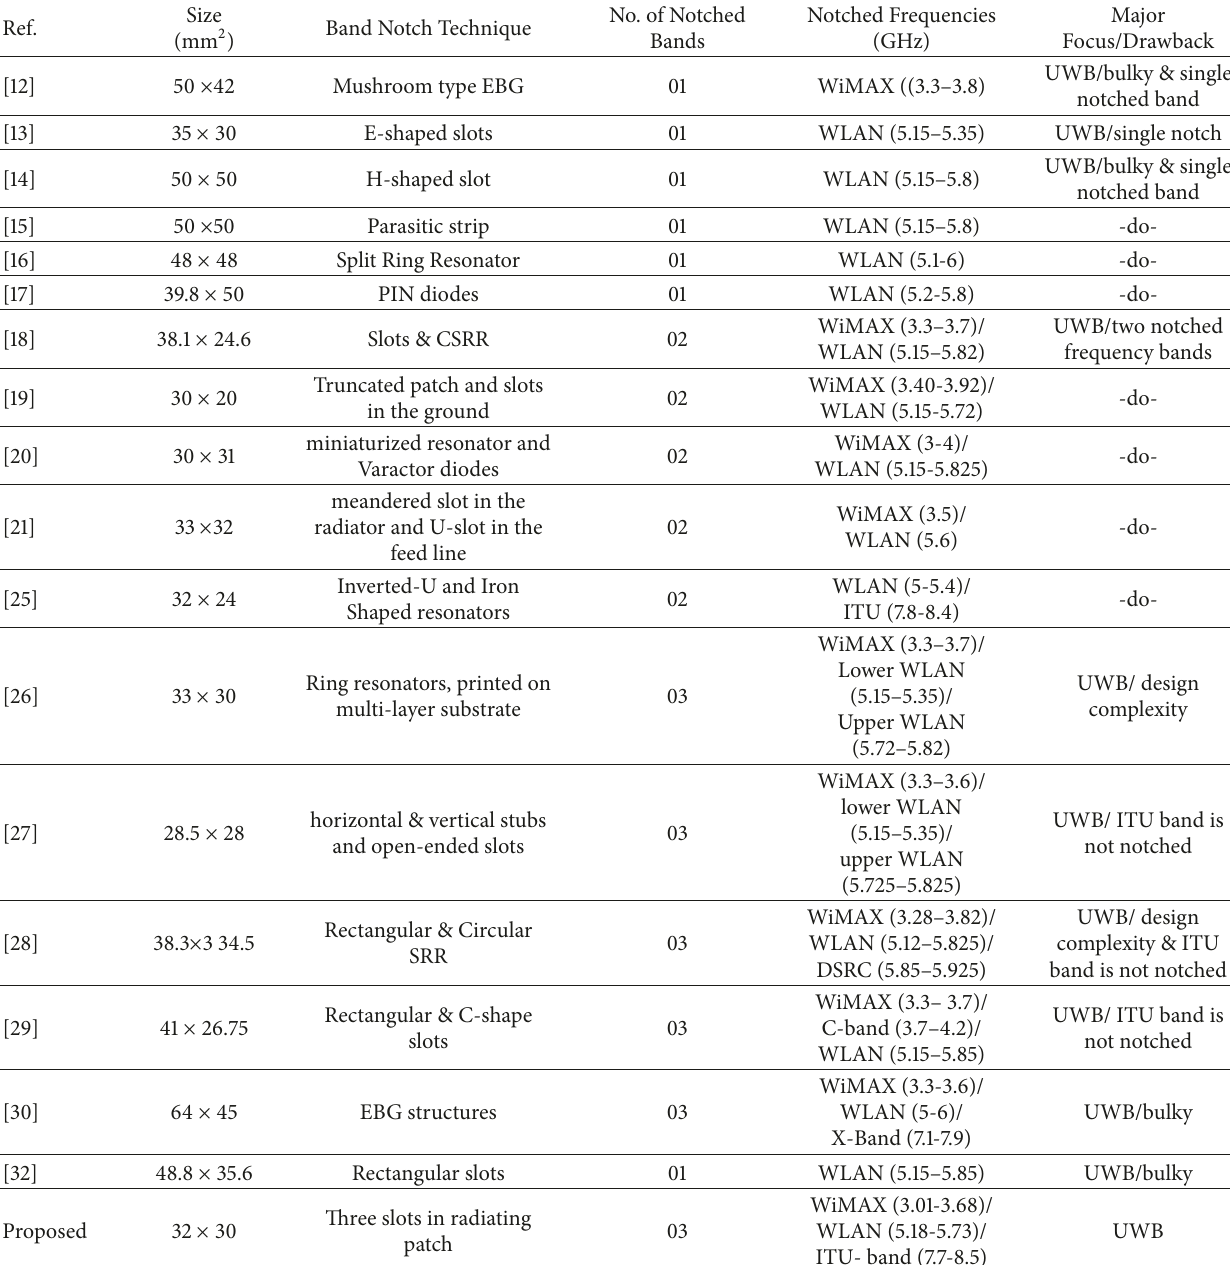
Table 1: Comparison with diverse range of existing UWB antenna with band-notch characteristics.